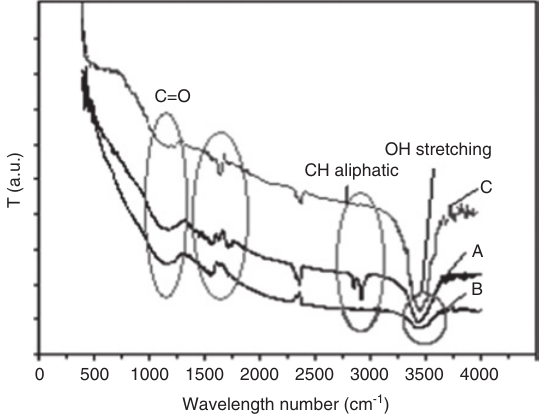
Figure 8: FTIR spectrum of isopropanol at (A) initial, (B) after being degraded at 380 nm by TiO /G, and (C) after being degraded at 2 380 nm by CdS-TiO /G. 2